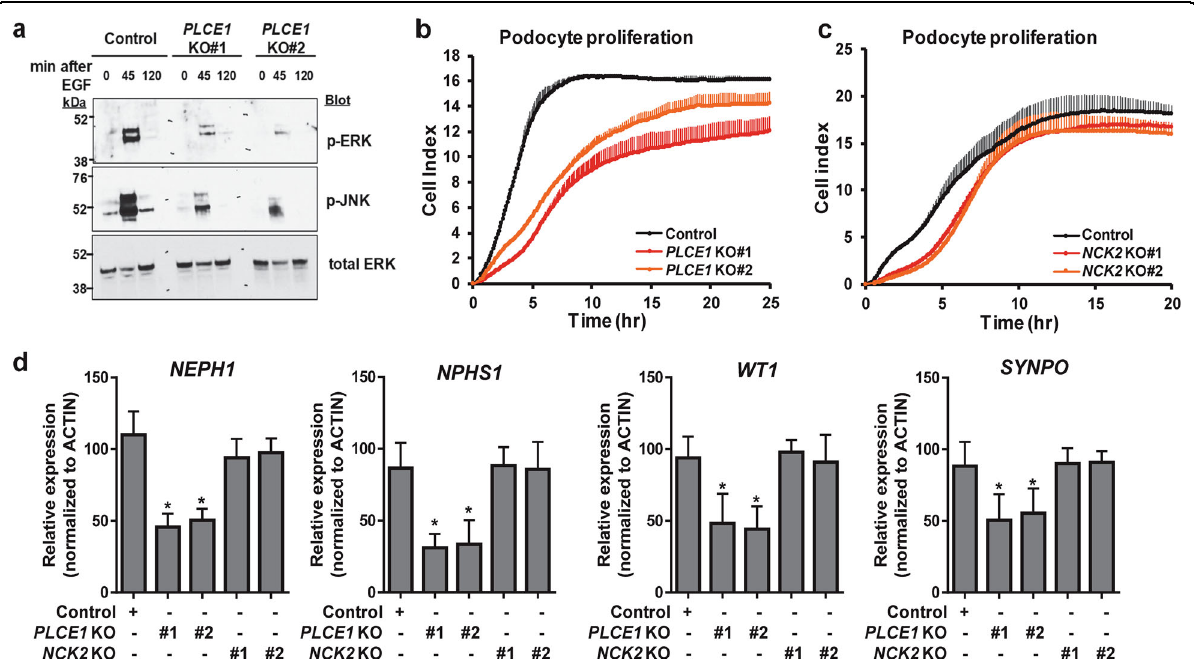
Fig. 6 PLCE1 regulates mitogen-activated protein kinases (MAPKs) in podocytes. a MAPK phosphorylation was induced by 20 ng/µl epidermal growth factor (EGF) treatment for 45 or 120 min. EGF-induced phosphorylation of ERK and JNK was signi fi cantly reduced in PLCE1 knockout (KO) podocytes. b , c The effects of PLCE1 or NCK2 KO on podocyte proliferation. PLCE1 KO podocytes exhibited lower proliferation ( b , red and orange lines), whereas NCK2 KO podocytes exhibited no signi fi cant differences in proliferation ( c , red and orange lines) with respect to the control cells (black line). Error bars are shown in one direction only for clarity and indicate standard deviations from more than three independent experiments. d Expression analysis of podocyte markers. The expression of NEPH1 , NPHS1 , WT1 , and SYNPO was measured by quantitative real-time PCR. The expression of podocyte markers was signi fi cantly reduced in PLCE1 KO podocytes, whereas no difference in the levels of podocyte markers was observed between NCK2 KO and control podocytes. Gene expression was normalized relative to that of actin. Data are presented as the mean ± standard deviation ( n = 3). * P <